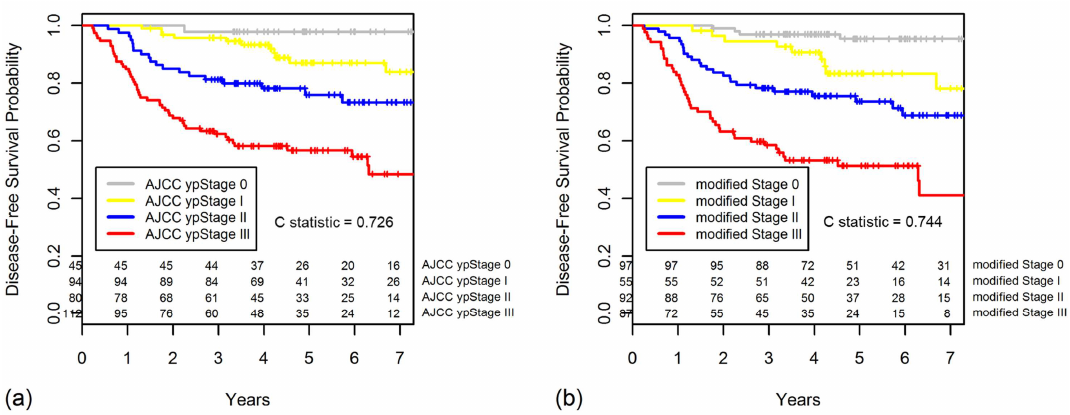
Figure 5. Kaplan-Meier curves for DFS comparing ( a ) the American Joint Committee on Cancer (AJCC) ypStaging and ( b ) the new modified staging